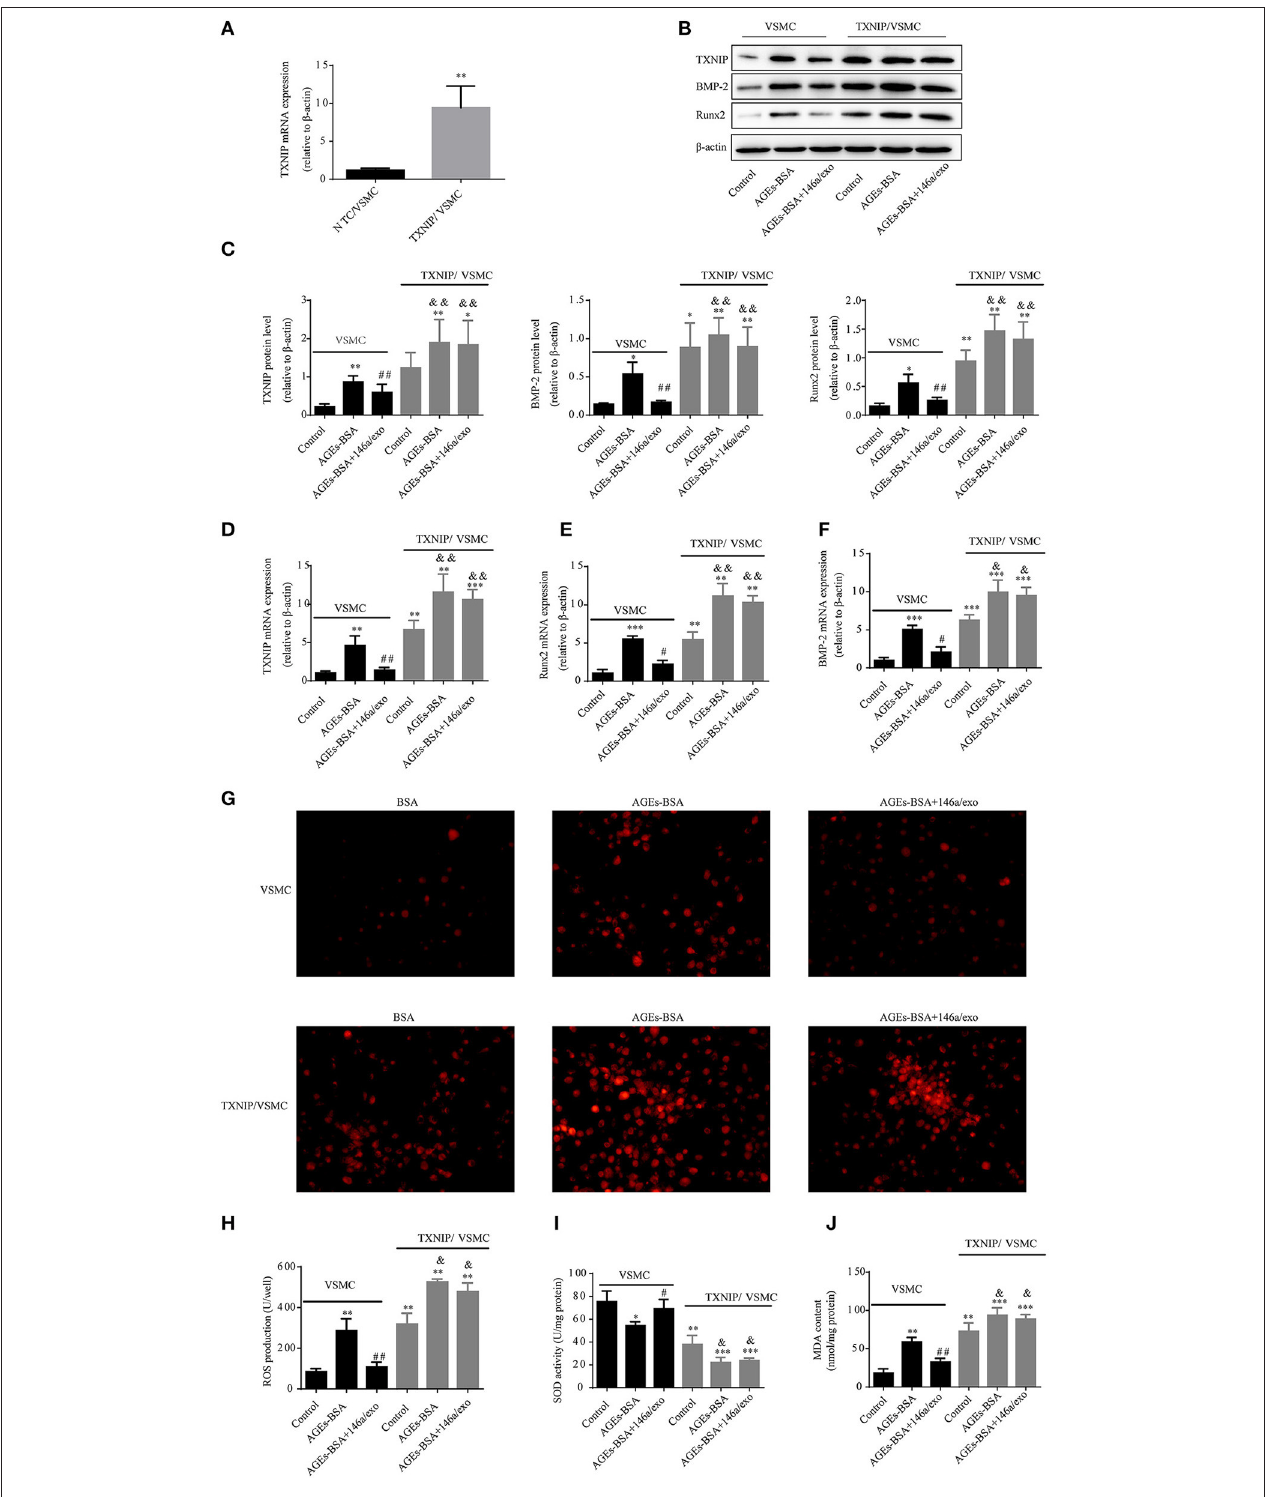
FIGURE 10 | TXNIP overexpression reverses the protective effects of 146a/exo. (A) Confirmation of transfection of VSMCs with a TXNIP-expressing plasmid by qPCR. (B,C) TXNIP, Runx-2, and BMP-2 protein levels by Western blotting. (D–F) TXNIP , Runx-2 , and BMP-2 mRNA levels by qPCR. (G) ROS concentrations and fluorescence micrographs of ROS levels. (H) ROS production. (I) SOD activity. (J) MDA content. * p < 0.05, ** p < 0.01, and *** p < 0.001 vs. VSMC control group; # p < 0.05 and ## p < 0.01 vs. VSMC AGEs-BSA group; and & p < 0.05 and && p < 0.01 vs. TXNIP/VSMC control group.